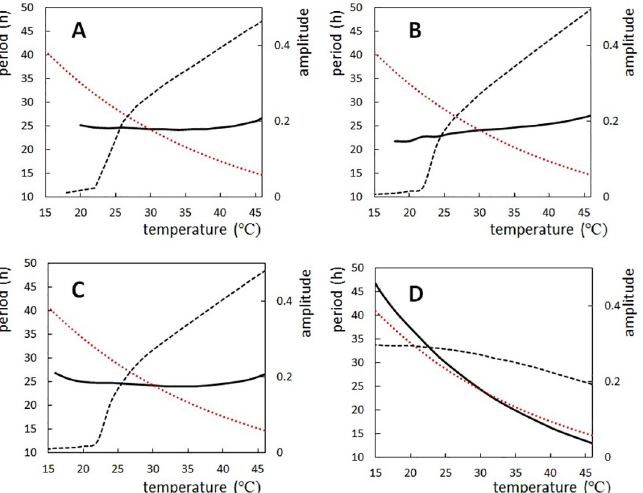
Fig 4. Temperature dependence of the period and amplitude of the simulated oscillations. Period (solid line) and amplitude (dashed line) of the ensemble-averaged phosphorylation level � D ð t Þ were calculated as functions of temperature with various modeling rules. Compared is the relative change of 1/rate of the process having the 10 k B T 0 activation energy (red dotted line). ( A ) Rule 1 (thermal attenuation of the negative feedback coupling), Rule 2 (thermal transformation of KaiB to a bindable conformation), and Rule 3 (temperature-insensitive ATPase reactions) applied (Case A). ( B ) Rule 1 and Rule 3 applied (Case B). ( C ) Rule 1 and Rule 2 applied (Case C). ( D ) Rule 2 and Rule 3 applied (Case D). N =